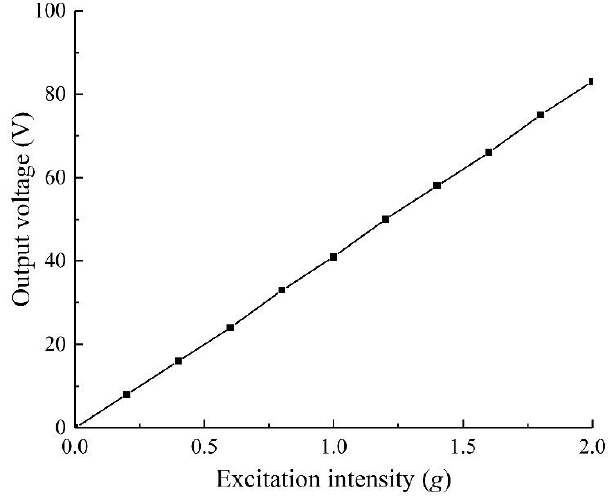
Figure 5. Correlation analysis of different excitation accelerations.